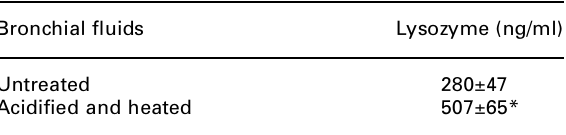
Table 1. Effects of acidification and heating on the lysozyme detection Bronchial fluids Lysozyme (ng/ml)